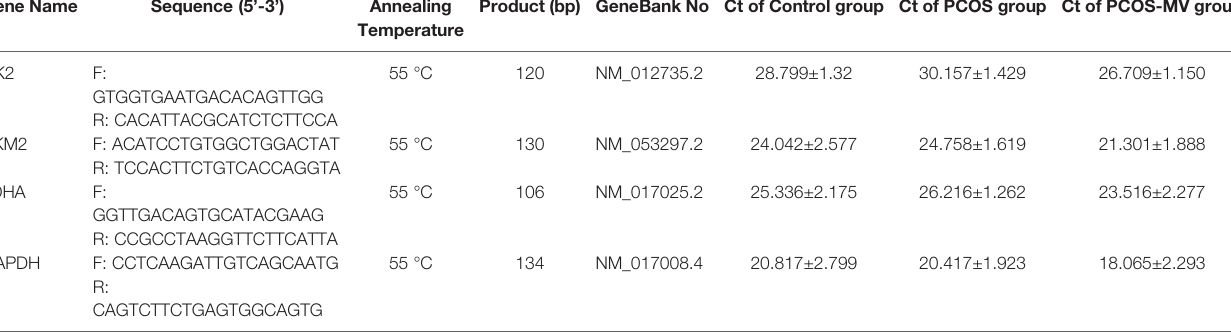
TABLE 1 | Primer sequences used for the qRT-PCR